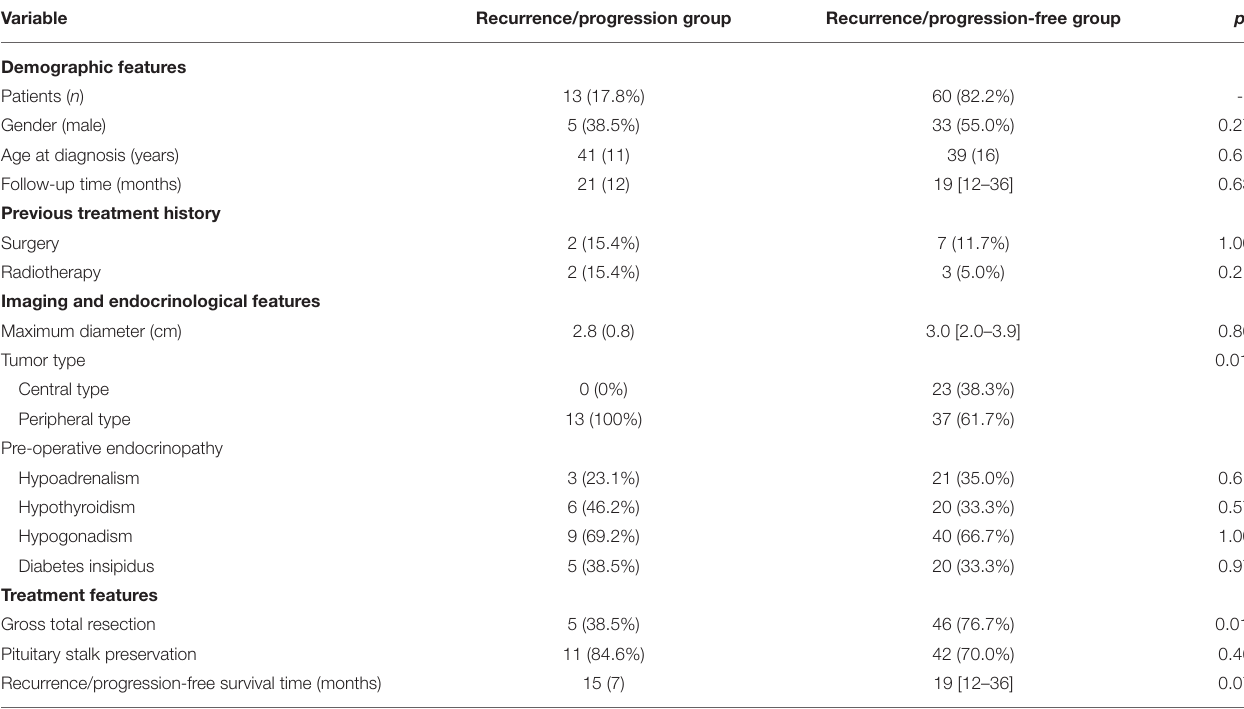
TABLE 2 | Comparison between patients with recurrence/progression and patients without. Variable